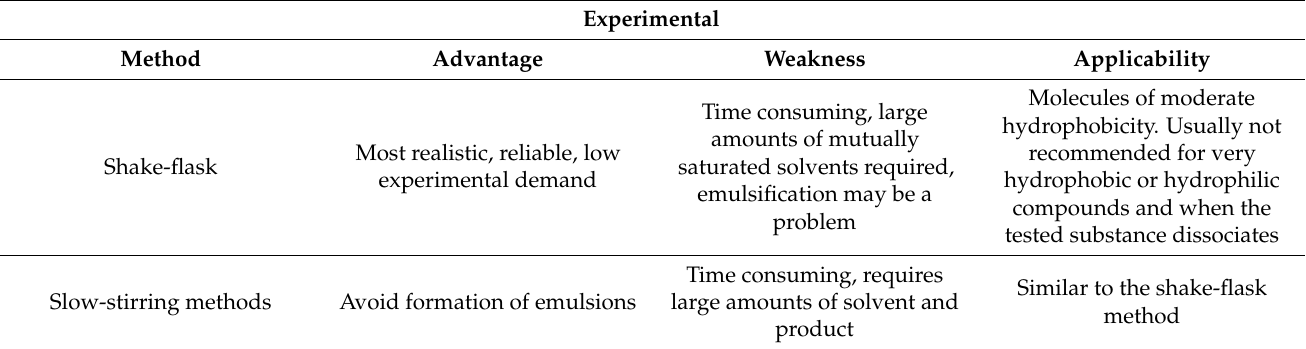
Figure 2. Common experimental methods employed to determine the partition constant values. Table 2. Some current experimental and computational methods employed to estimate partition constant values in oil − water and in octanol − water binary systems.